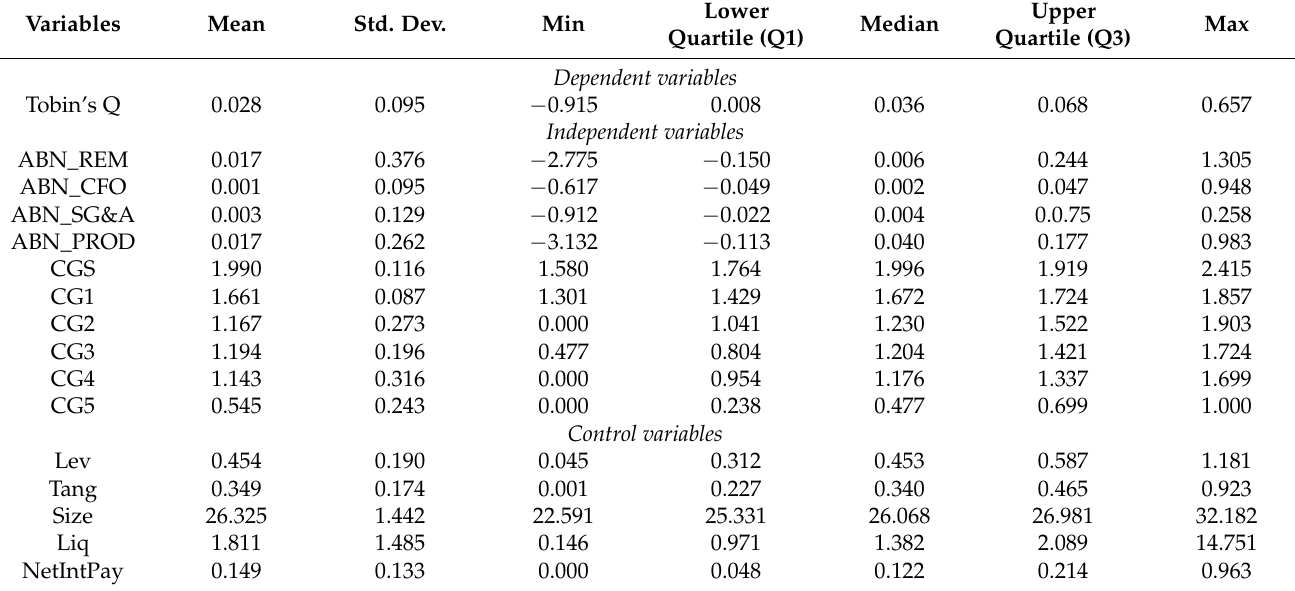
Table 1. Descriptive